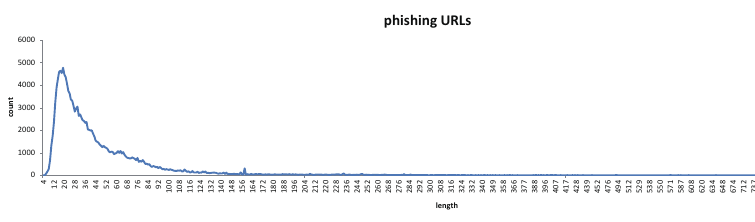
Figure 13. Distribution of URL length in D1.